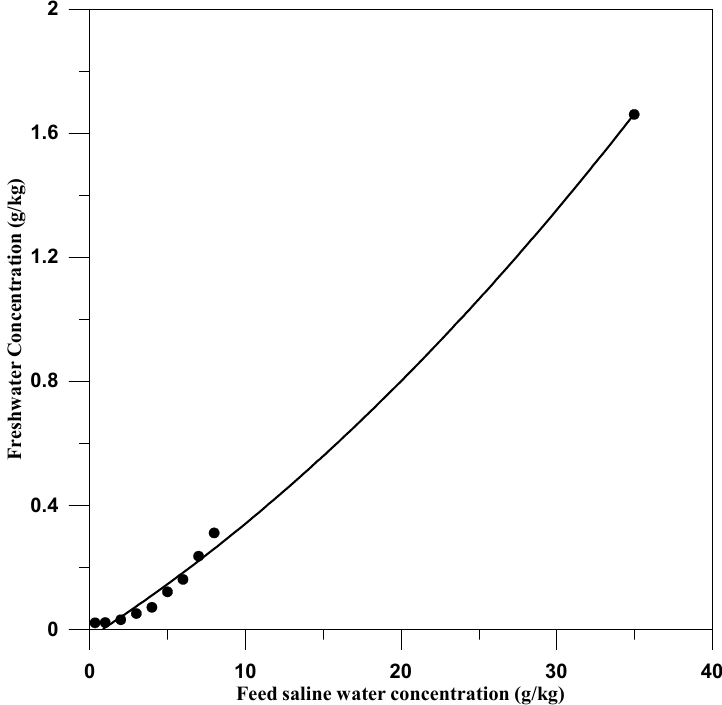
Figure 10. Productivity concentration using the ultrasonic water